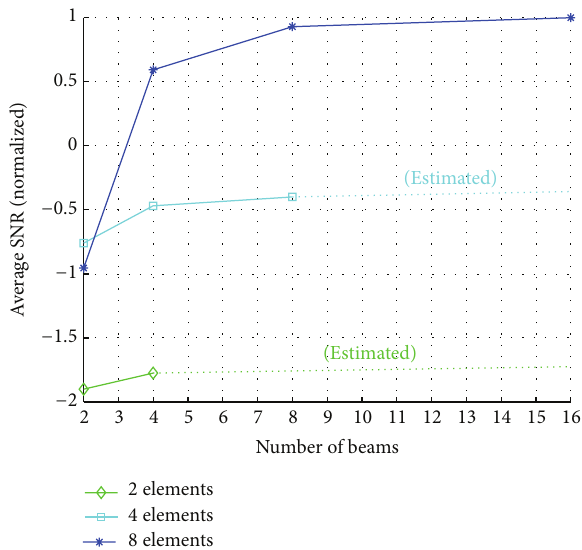
Figure 9: Average SNR as a function of the number of beam- pointing directions for different array